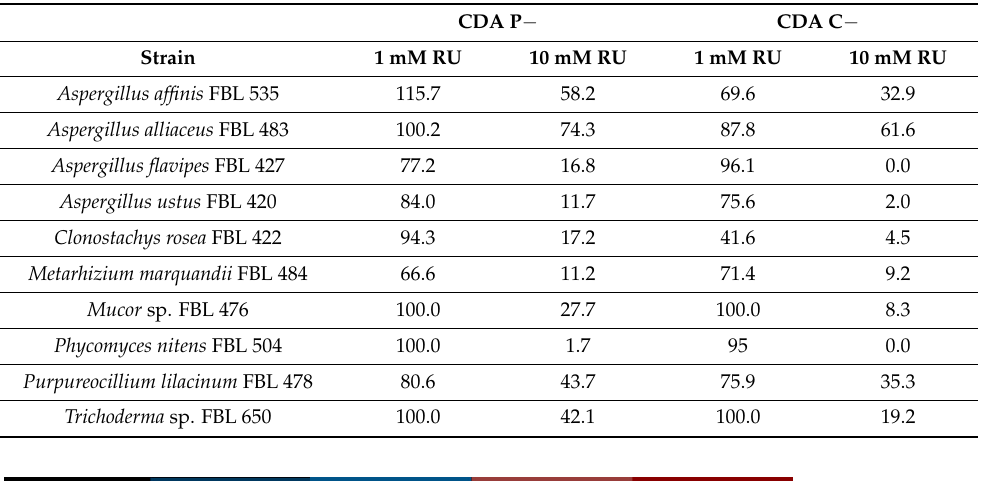
Table 5. Tolerance index (R t :R c ) of the tested species exposed to Roundup as the only source of P or C on enriched CDA.